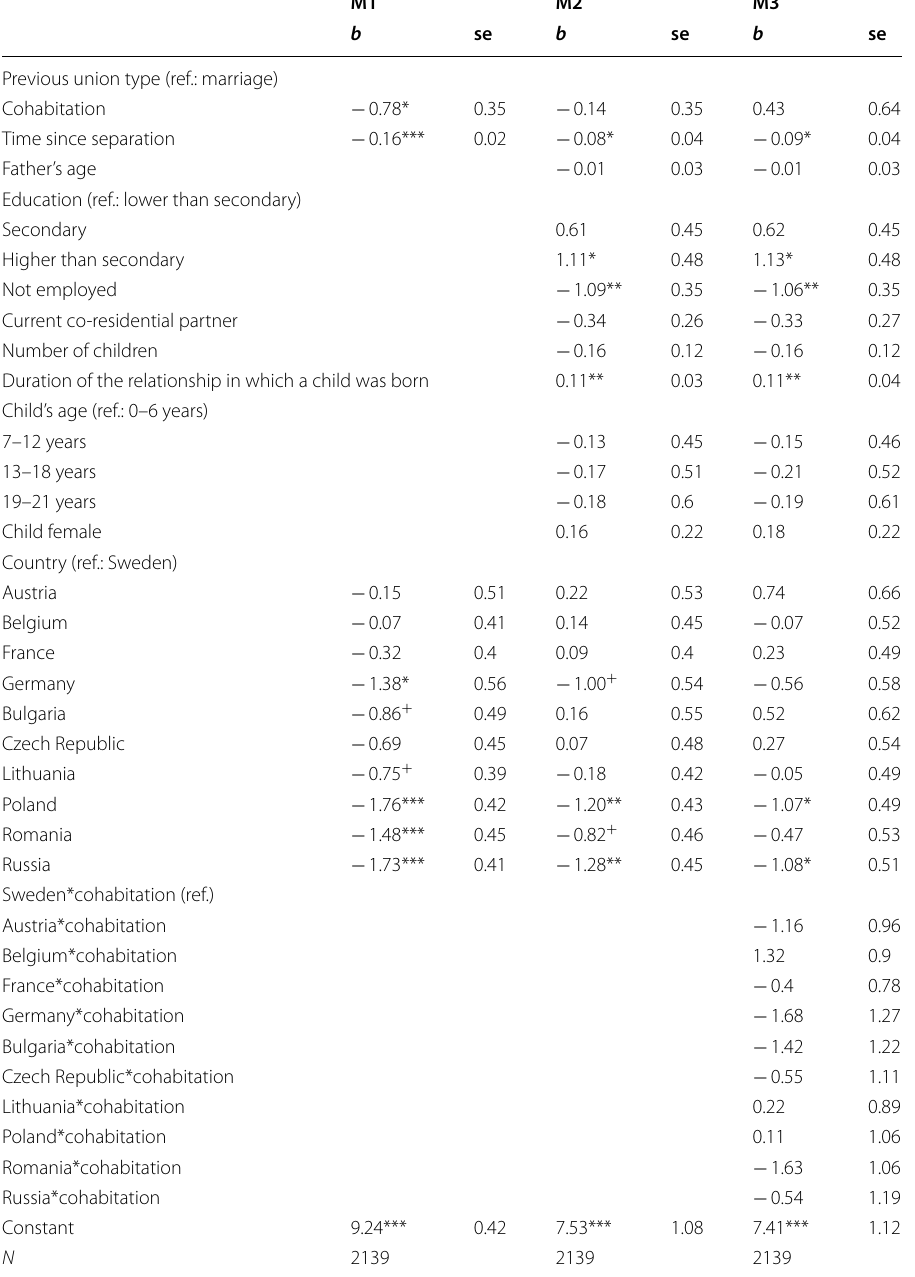
Table 6 Father’s satisfaction with the quality of relation with a child including children aged